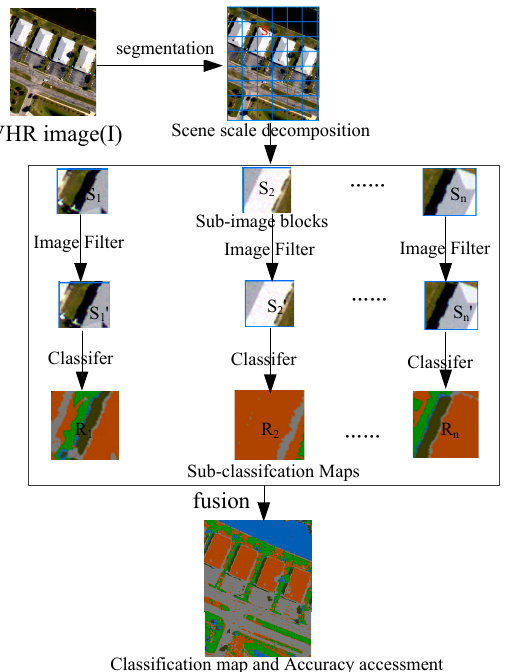
Figure 2. Flowchart of the proposed system based on OSSD coupled with image filter.